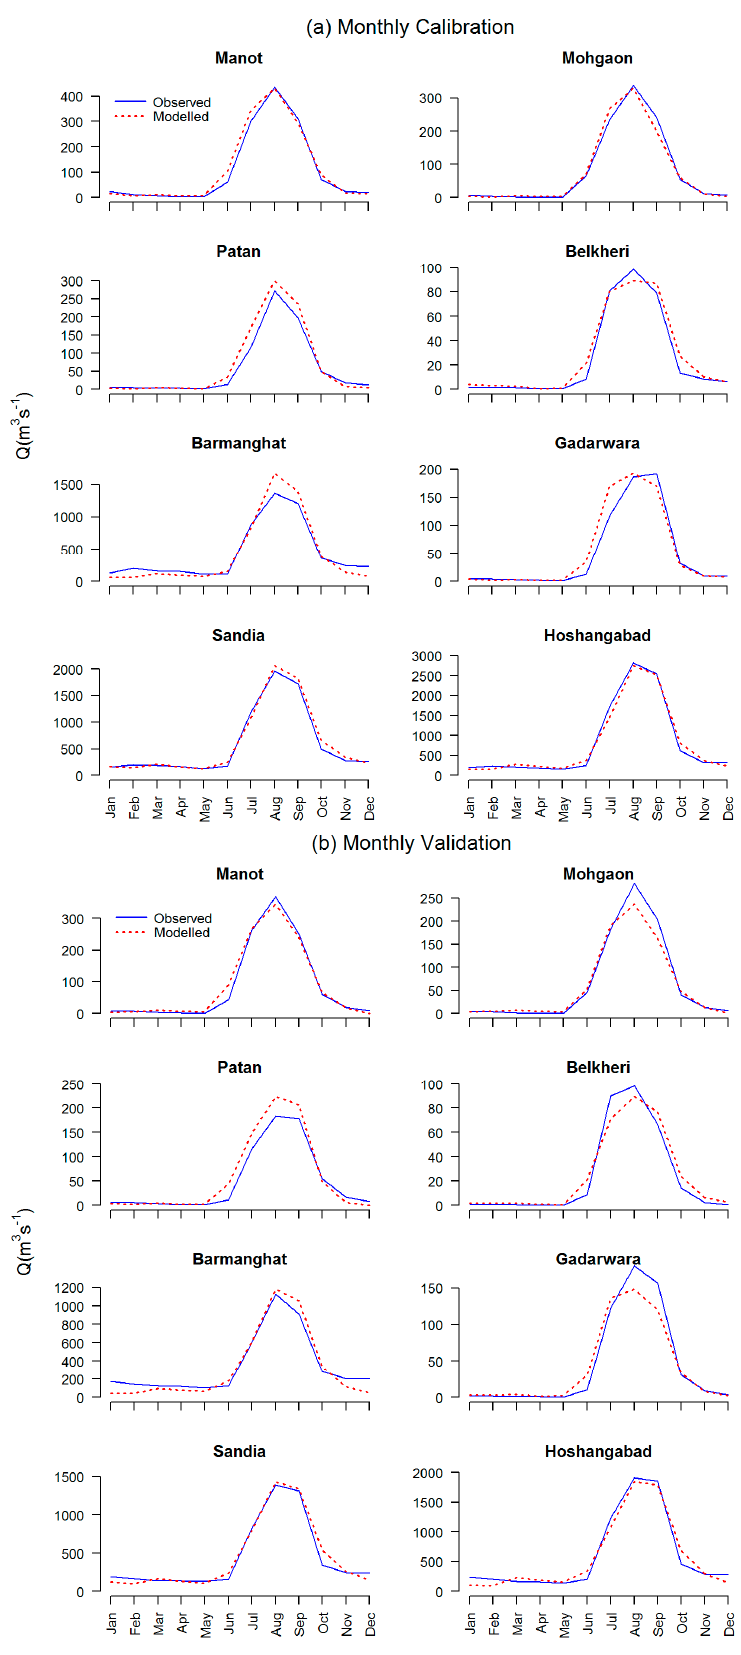
Figure 4. Average monthly observed and modelled output at the eight gauging sites for ( a ) Calibration; ( b ) Validation.